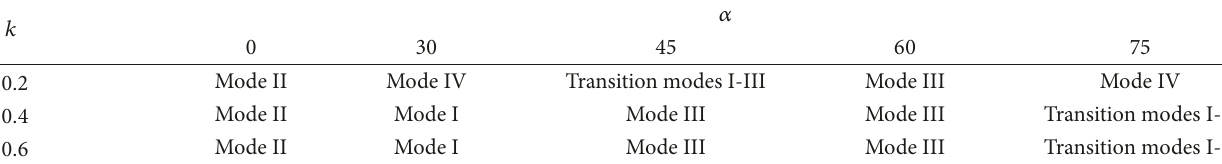
Table 7: Microscopic parameters for